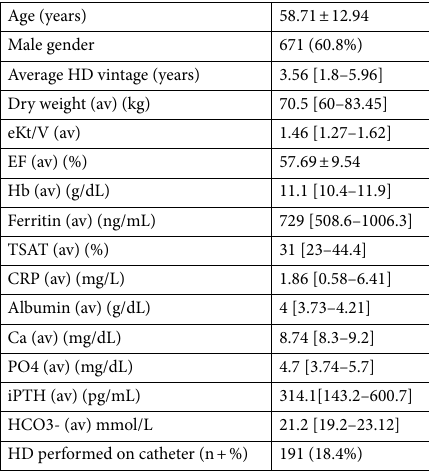
Table 1. General characteristics of the cohort at inclusion (n = 1034). av average, kg kilograms, eKt/V effective Kt/V, EF ejection fraction, Hb Hemoglobin, g/dL grams/deciliter, ng/mL nanograms/milliliter, TSAT transferrin